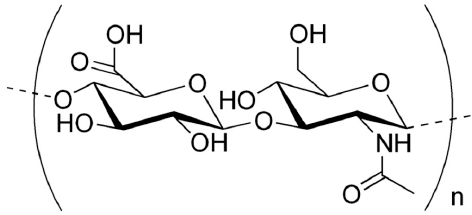
Figure 1. Chemical structure of HA polymer.